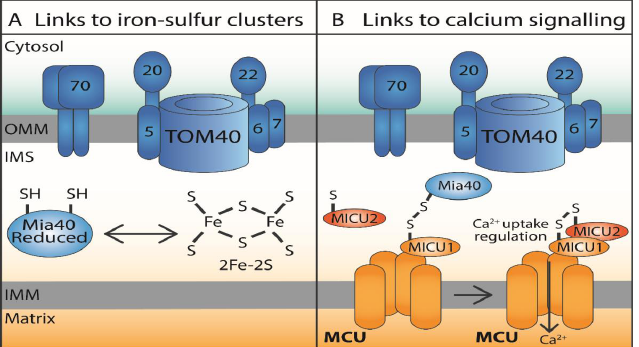
Figure 4. Potential signalling mechanisms linked to the MIA pathway. ( A ) Links between Mia40/CHCHD4 and iron–sulfur clusters (ISCs). Mia40/CHCHD4 has been previously reported